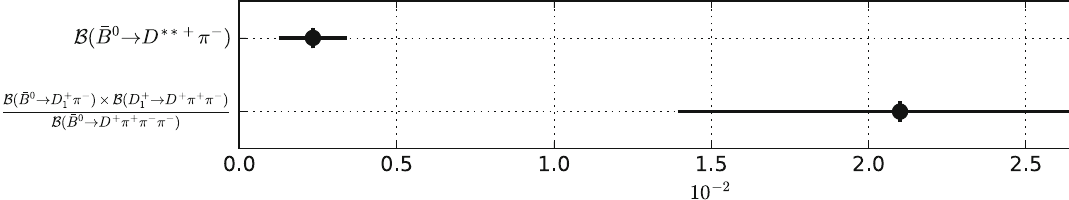
Fig. 78 Summary of the averages from Table103